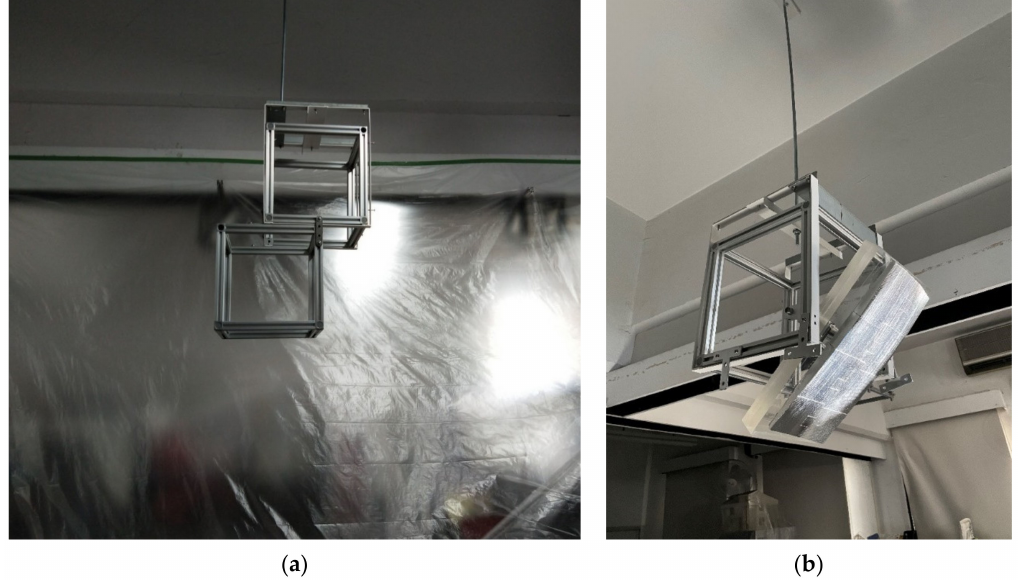
Figure 23. ( a ) Aluminum outer frame of a light cube installed in the field and; ( b ) combination of a freeform reflector and an aluminum outer